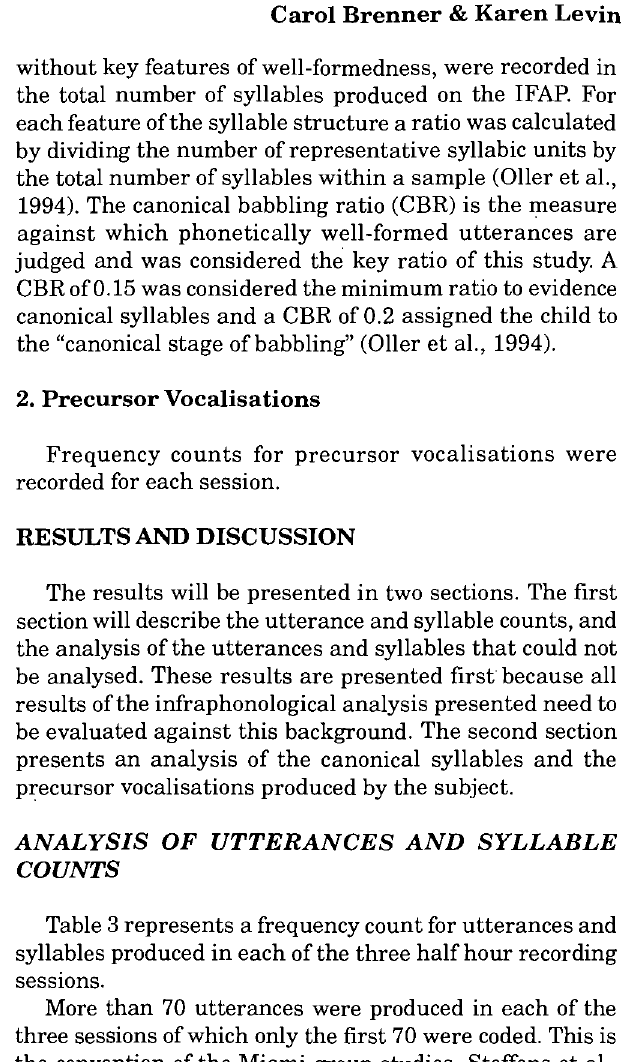
TABLE 2: Percentage inter-rater reliability for three sessions